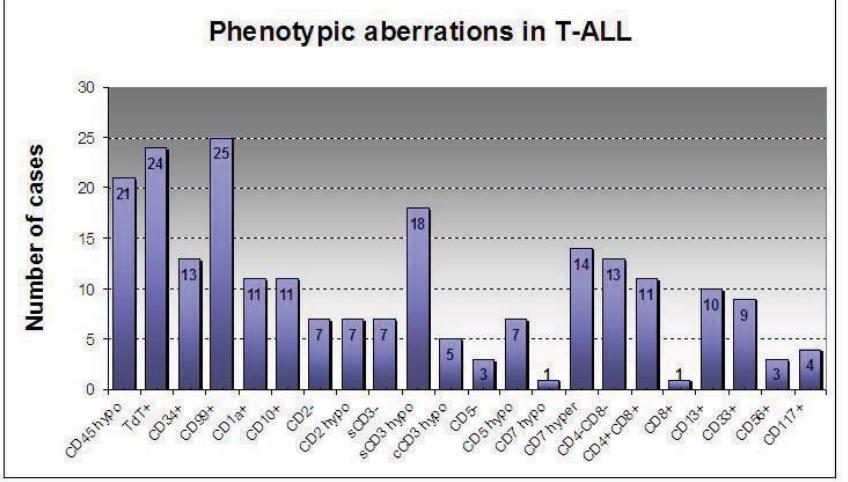
Figure 4. The most common phenotypic aberrations in